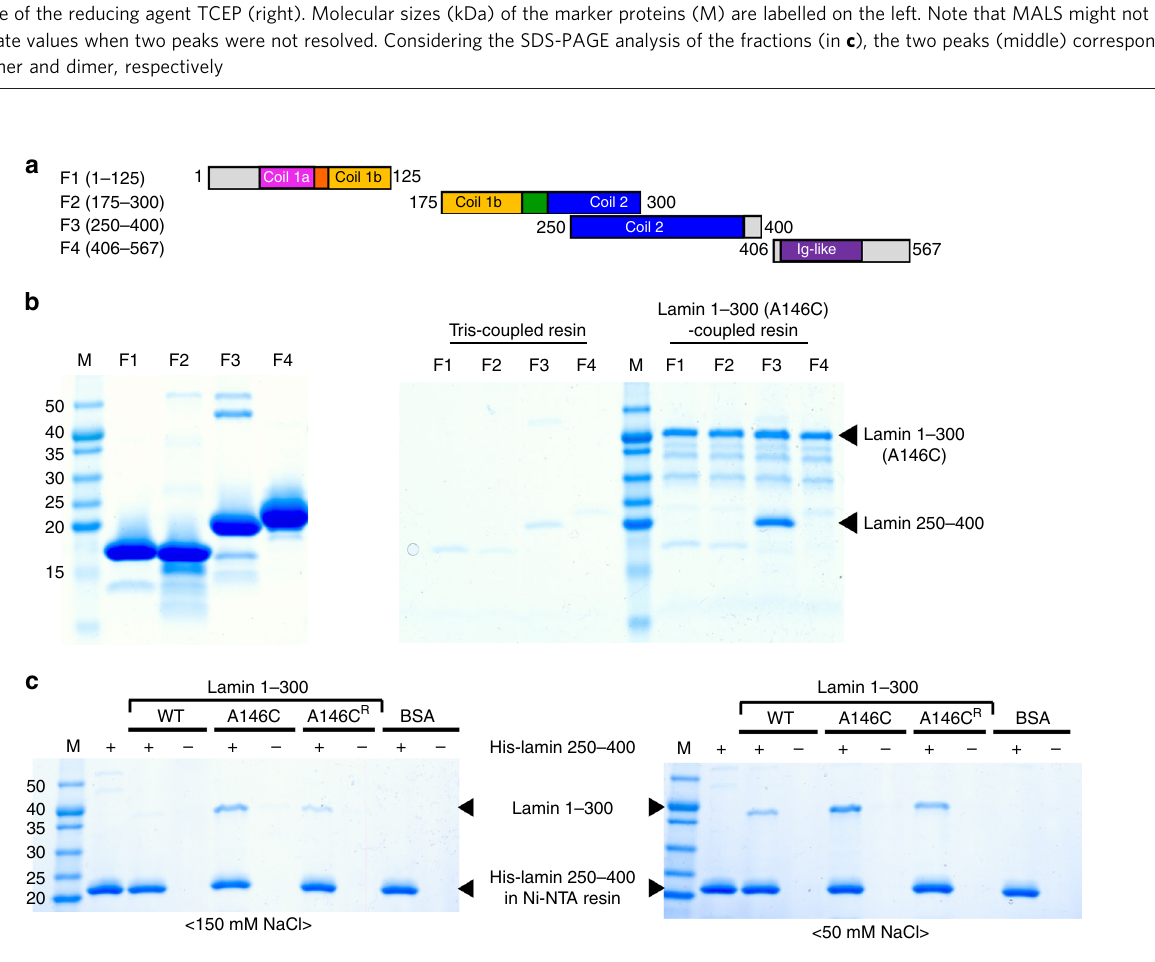
Fig. 4 Direct binding between the lamin fragments depending on the A11 interaction. a Lamin fragments (F1 – F4) were used for the binding assay. The sub- domains are coloured differently as shown in Fig. 1a. The start and end residues of the four fragments are indicated. b Identi fi cation of the binding partners of the lamin 300 fragment. Four puri fi ed fragments are shown in the left SDS-PAGE gel. An in vitro pull-down assay was conducted using the immobilized lamin 300 A146C mutant on CNBr-activated resin. Four candidate fragments (66 μ M) were incubated with lamin 300 A146C-coupled resin or Tris- coupled resin under the non-reducing condition (right SDS-PAGE gel). c Comparison of binding af fi nity between the lamin 300 variants and F3 depending on A11 interaction. An in vitro pull-down assay was conducted using His-F3 (residues 250 – 400)-bound Ni-NTA resin. BSA and wild type (WT; dimer), non-reduced A146C (A146C; tetramer), and reduced A146C (A146C R ; dimer) of the lamin 300 fragment were incubated on the empty ( − ) or His-F3- bound ( + ) Ni-NTA resins. The resins were pre-equilibrated and washed with the 20 mM Tris-HCl (pH 8.0) buffer containing 150 mM (left) or 50 mM NaCl (right). For A146C R , the buffer was supplemented with 2 mM TCEP (reducing agent). The bound proteins in the resins were analysed using SDS- PAGE. Molecular weights (kDa) of the marker (M) are labelled on the phosphate-buffered saline, based on K D values (Supplementary Fig. 7). Consistent results were obtained in the nuclear shapes and Fig. 6b). In contrast, we observed that the L59R mutation the distribution of the lamin A/C when the mutant lamin genes increased the eA22 interaction in the high salt buffer (Fig. 8a were overexpressed in the cell lines (HT1080 and SHSY5Y). right). Furthermore, isothermal titration calorimetry (ITC) results showed ~40-fold higher binding af fi nity of L59R mutation than the wild type against the C-terminal part of coil 2 in the